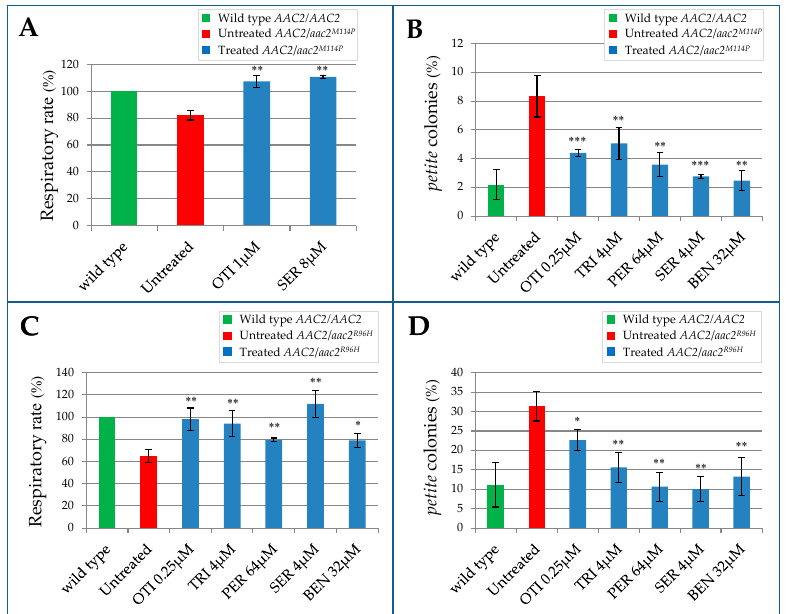
Figure 5. Effect of the identified drugs on the heteroallelic strains. ( A ) Oxygen consumption rate of the AAC2/aac2 M114P strain grown in SC medium (without uracil) at 37 °C supplemented with 0.6% glucose. ( B ) Determination of petite frequency of the heteroallelic AAC2/aac2 M114P strain grown in YP medium supplemented with 2% glucose. ( C ) Oxygen consumption rate of AAC2/aac2 R96H strain grown at 37 °C in YP medium supplemented with 0.6% glucose. ( D ) Determination of petite frequency of the AAC2/aac2 R96H strain grown in YP medium at 37 °C supplemented with 2% glucose. For the oxygen consumption rate analysis ( A , C ), values were normalized to the homoallelic ( AAC2 / AAC2 ) wild type strain and represented as the mean of at least four independent experiments ± SD. For petite analysis ( B , D ) more than 4000 colonies/strain were scored. All values are means of three independent experiments. Statistical analysis was performed using an unpaired, two-tailed Student’s t -test comparing treated (blue bars) versus untreated mutant (red bar): * p < 0.05; ** p < 0.01; *** p < 0.001. OTI = otilonium bromide, PER = pergolide mesylate, TRI = trifluoperazine 2HCl, SER = sertraline HCl, BEN = benzydamine HCl.